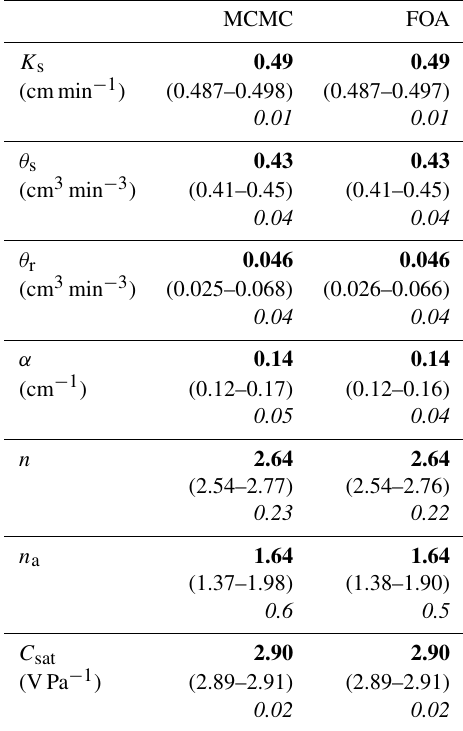
Table 3. Estimated mean values (bold), confidence intervals (CIs) and size of the posterior CIs (italic) with MCMC and FOA ap- proaches for scenario 1.